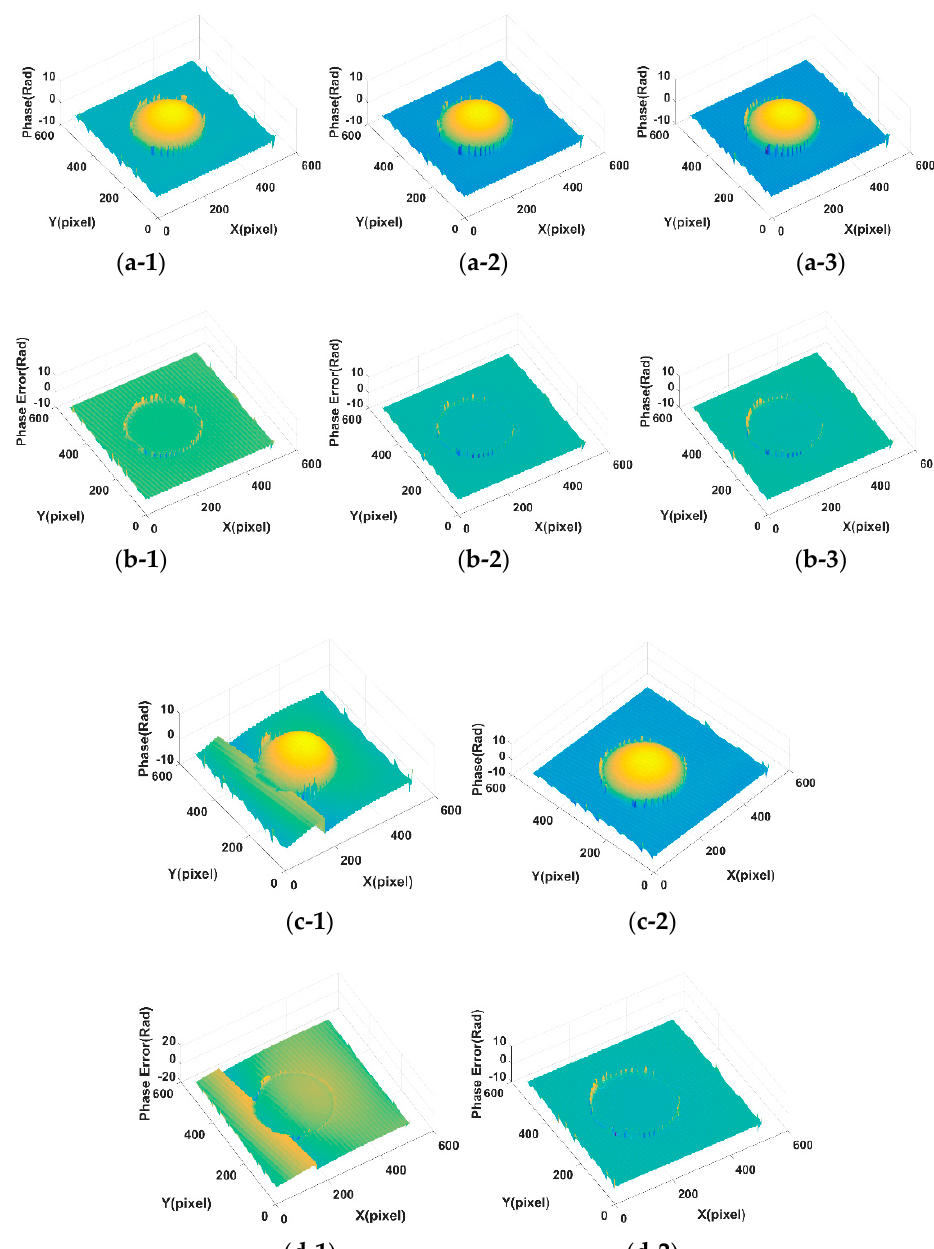
Figure 11. The retrieved phase and phase error for Figure 3b by Fourier transform under optimal CrossUV, SE and SSIMV and Shearlet transform method under different decomposition scales. ( a-1 ) Phase under optimal CrossUV for Figure 3b; ( a-2 ) Phase under optimal SE for Figure 3b; ( a-3 ) Phase under optimal SSIMV for Figure 3b; ( b-1 ) Phase error under optimal CrossUV for Figure 3b; ( b-2 ) Phase error under optimal SE for Figure 3b; ( b-3 ) Phase error under optimal SSIMV for Figure 3b; ( c-1 ) Phase under decomposition layer of 3 by Shearlet transform by Figure 3b; ( c-2 ) Phase under decomposition layer of 4 by Shearlet transform by Figure 3b; ( d-1 ) Phase error under decomposition layer of 3 by Shearlet transform by Figure 3b; ( d-2 ) Phase error under decomposition layer of 4 by Shearlet transform by Figure 3b.